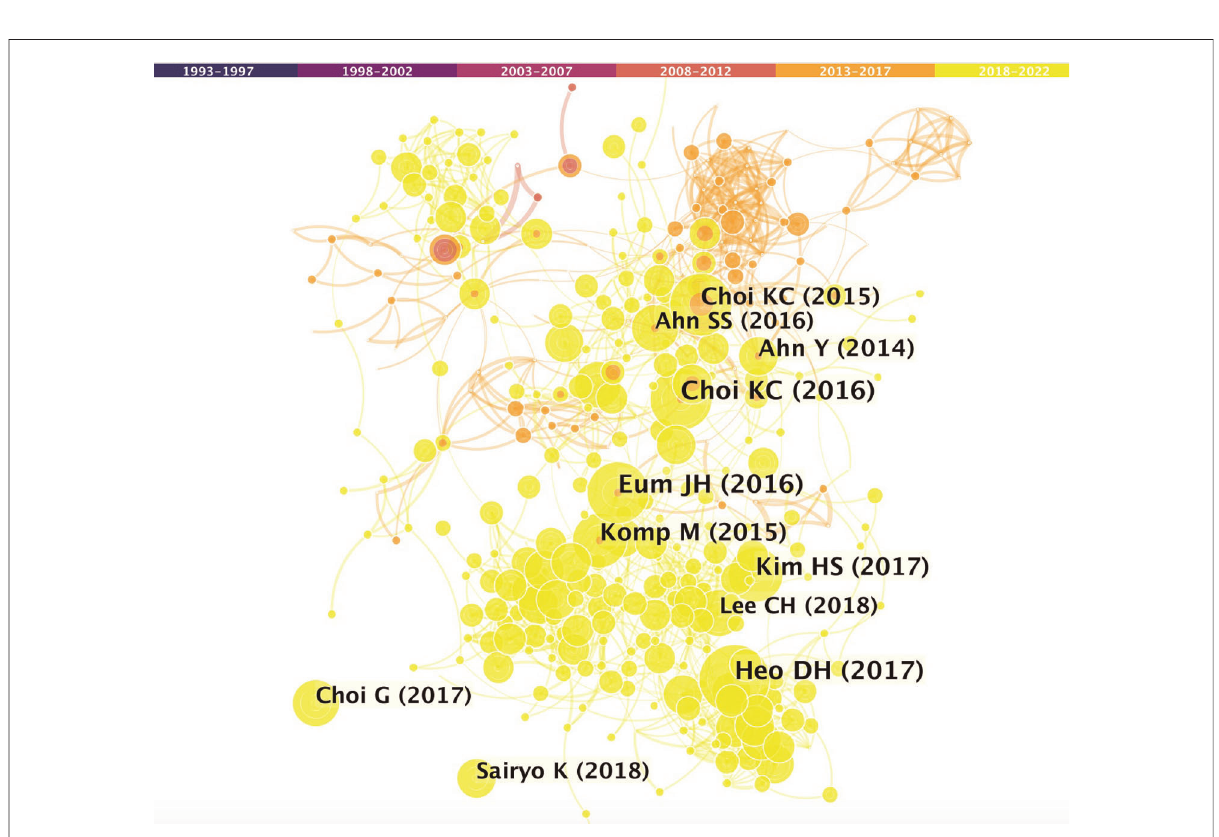
FIGURE 5 Co-operation network of cited